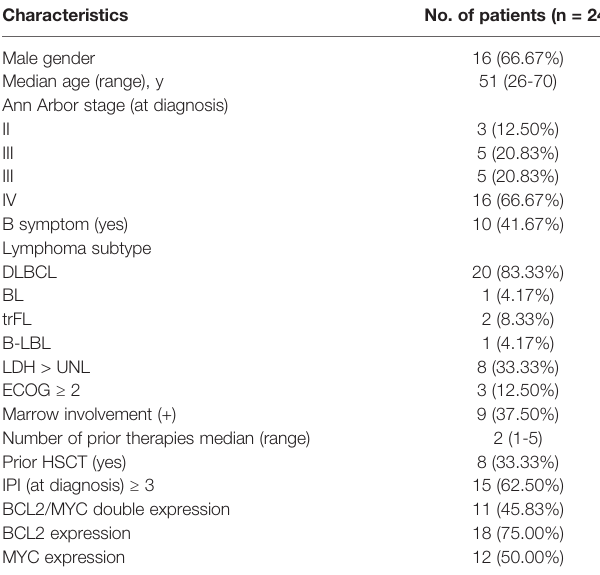
TABLE 1 | Patient baseline